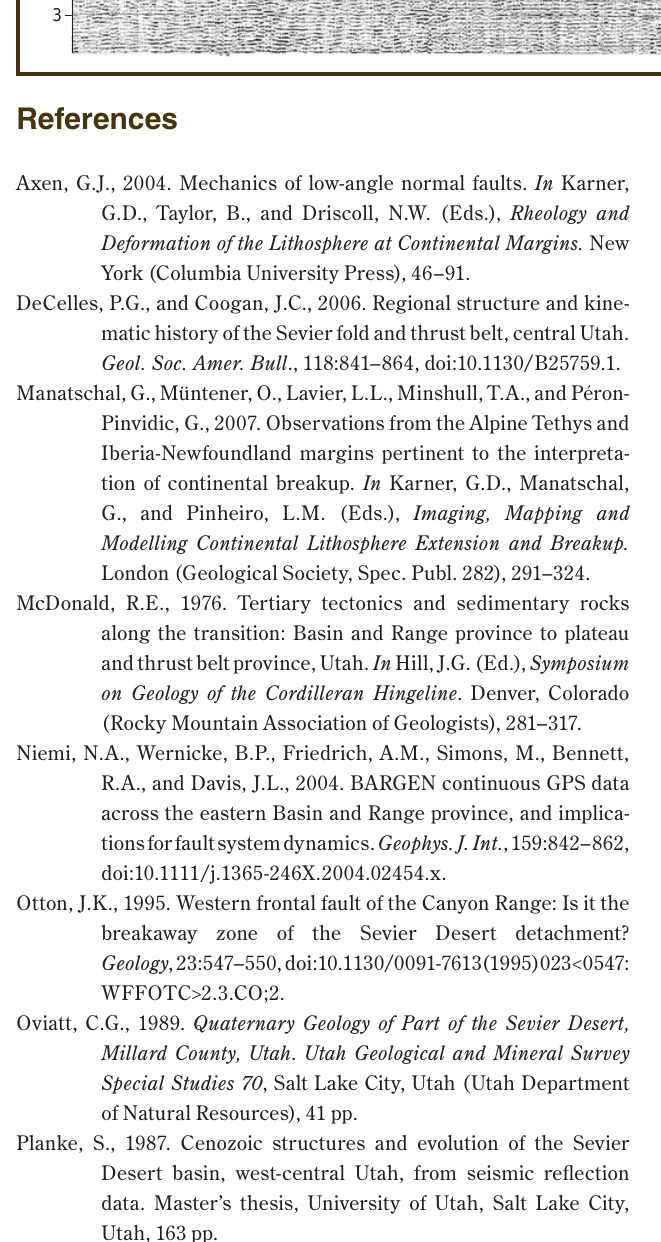
Figure 3. Examples of seismic reflection profiles from the Sevier Desert basin (see Fig. 2 for location). [A] Part of COCORP Utah Line 1, with interpretation of the Sevier Desert detachment from Von Tish et al. (1985). [B] A portion of Vastar Resources, Inc. Line V-11, with interpretation modified from Planke (1987). Projected wells: GG, Gulf Gronning; AHR, ARCO Hole-in-Rock. Line V-11, located ~3 km north of the Hole-in-Rock well, is the profile that best illustrates the geological structure in the vicinity of the